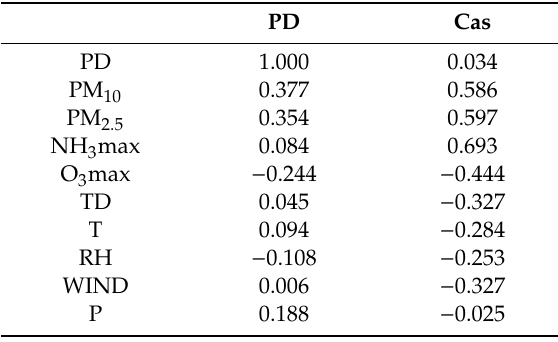
Table 1. The correlation vectors between population density (PD), PM 2.5 , PM 10 , NH 3 , O 3 , dew-point temperature (TD), temperature (T), relative humidity (RH), wind (W), pressure (P) and number of SARS-CoV-2 cases in Italian provinces